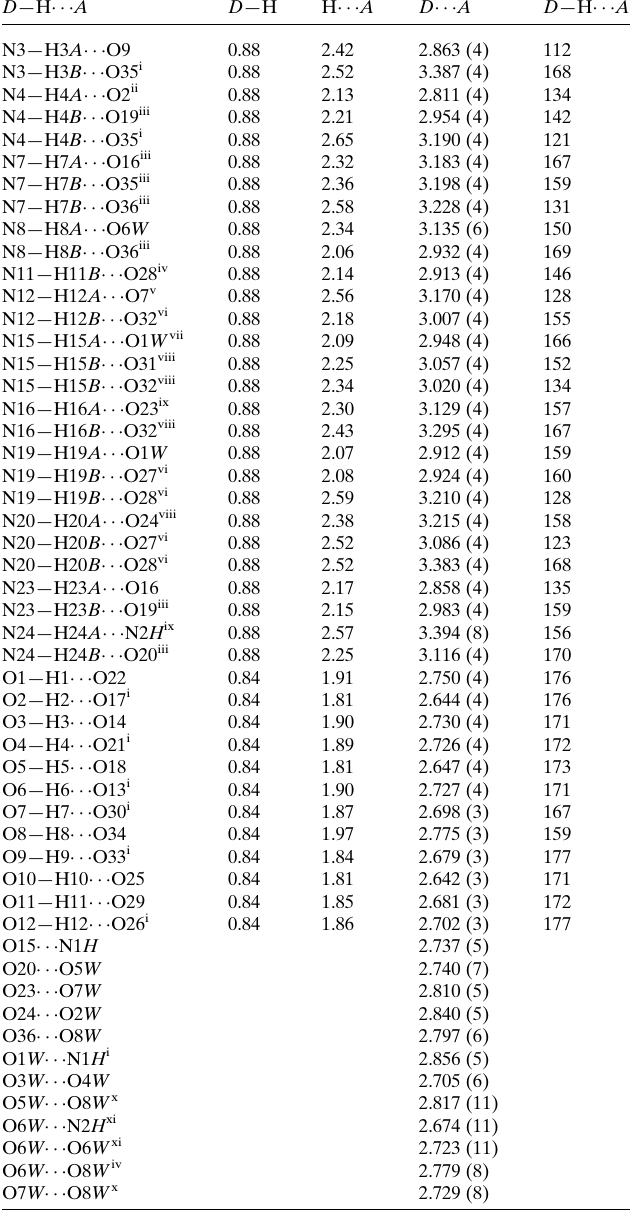
Table 2 Hydrogen-bond geometry (A˚ , (cid:5)